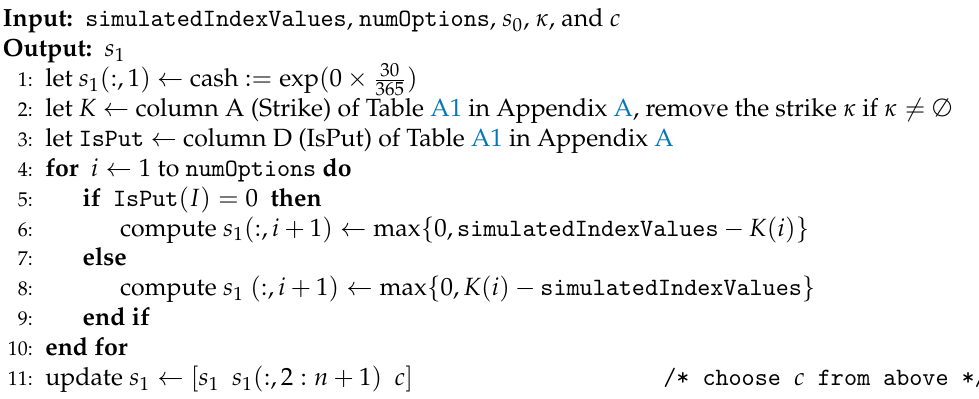
Algorithm 1: Return the payoffs of the assets based on the simulated values of the index ( PayoffMatrix